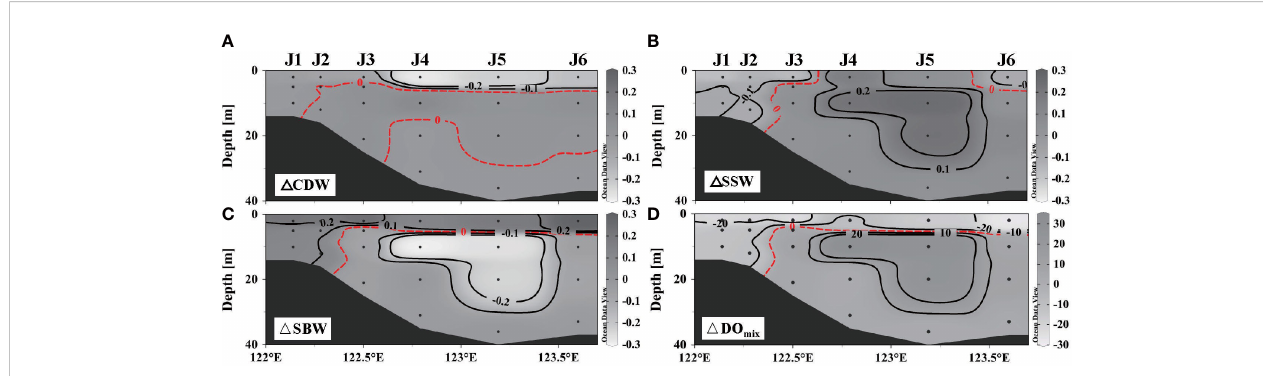
FIGURE 5 Differences of fractions in three end-member water masses and dissolved oxygen (DO) supplemented by physical mixing along section J: (A) Changjiang diluted water, (B) shelf surface water, (C) shelf bottom water, and (D)